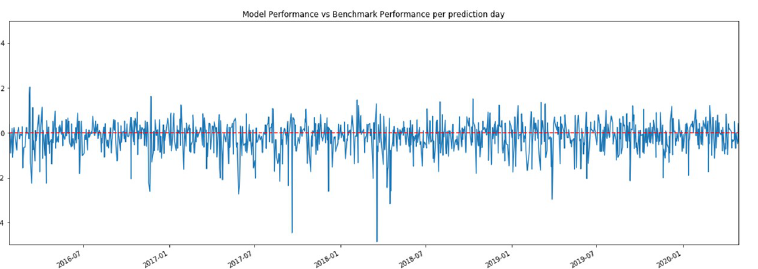
Fig 6. Model performance vs benchmark performance per prediction day. The overall performance comparison between the chosen topic model and benchmark model measured by RMSE each day. Positive peaks indicates the topic model outperformed the benchmark model and vice